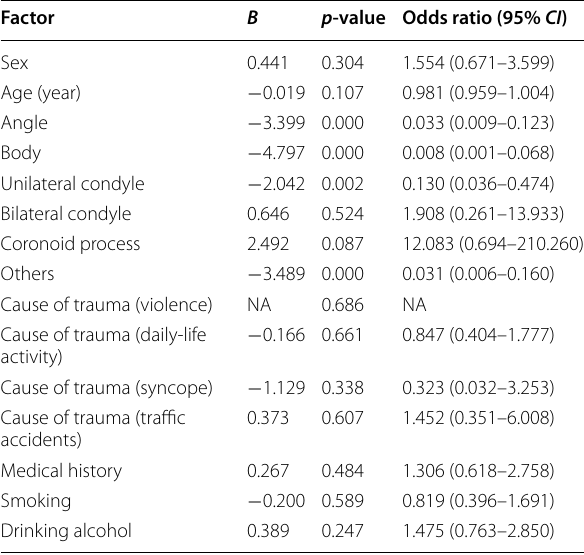
Table 6 Logistic regression analysis of patients with unilateral